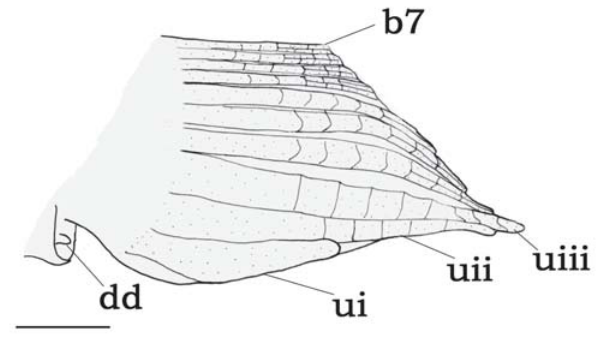
paratype, 43.3 mm SL. Left side lateral view. Abbreviations: b7 , branched seventh ray; dd , deferent duct; ui , unbranched first ray; uii , unbranched second ray; uiii , unbranched third ray. Scale bar = 1